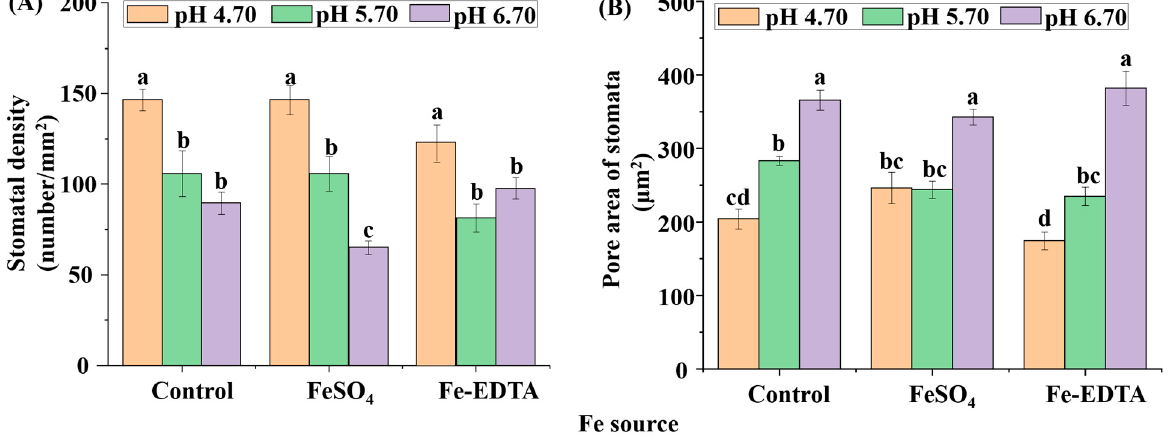
Figure 5. The stomatal density ( A ) and pore area of the stomata ( B ) of H. macrophylla leaves after 60 days of culture. Lowercase letters indicate significant differences calculated by Duncan’s multiple range test at p ≤ 0.05. Vertical bars indicate the standard error ( n = 3).